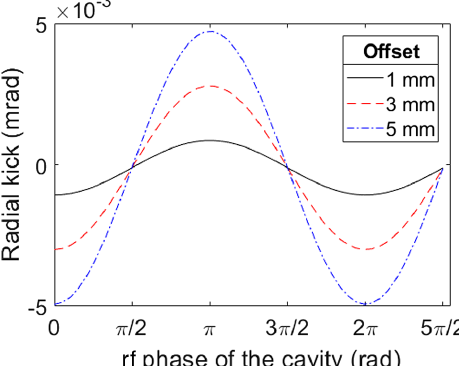
of 1 mm (solid line), 3 mm (dashed line), and 5 mm (dotted- dashed), respectively, as a function of the cavity phase (the vertical offset is fixed to 2 mm).